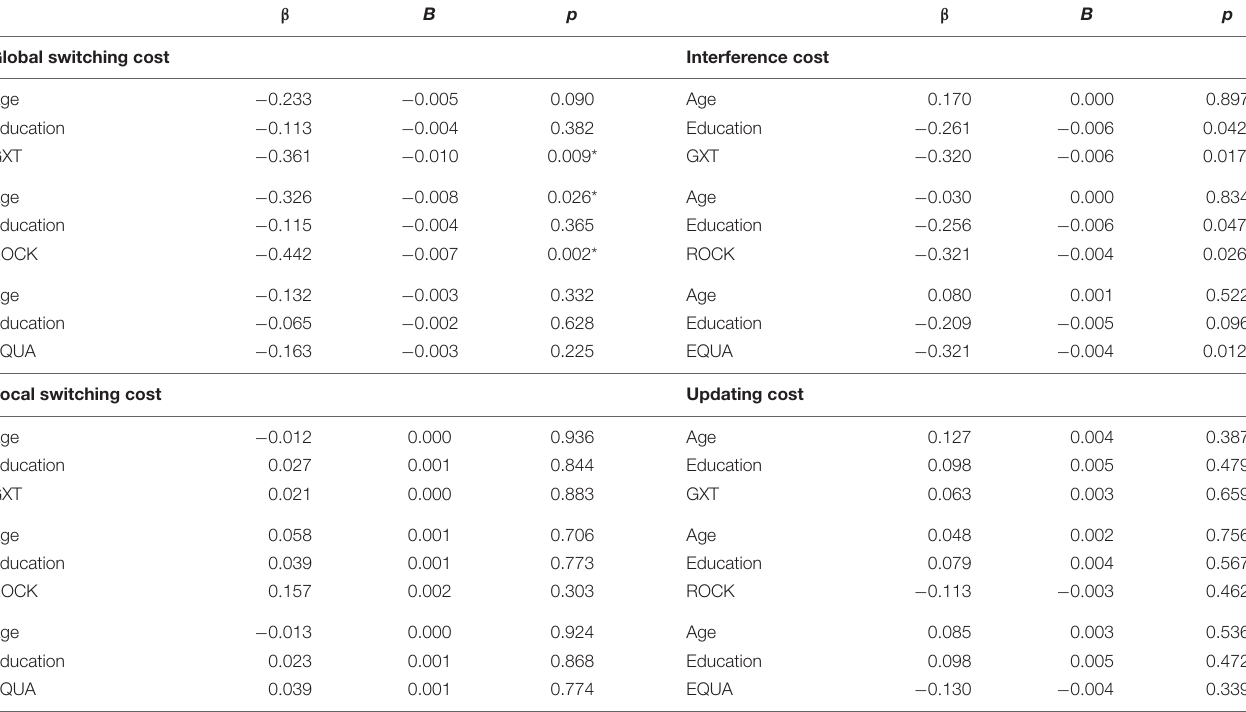
TABLE 3 | Regression coefficients of the demographic and cardiorespiratory fitness predictors of executive function performance. β B p β B